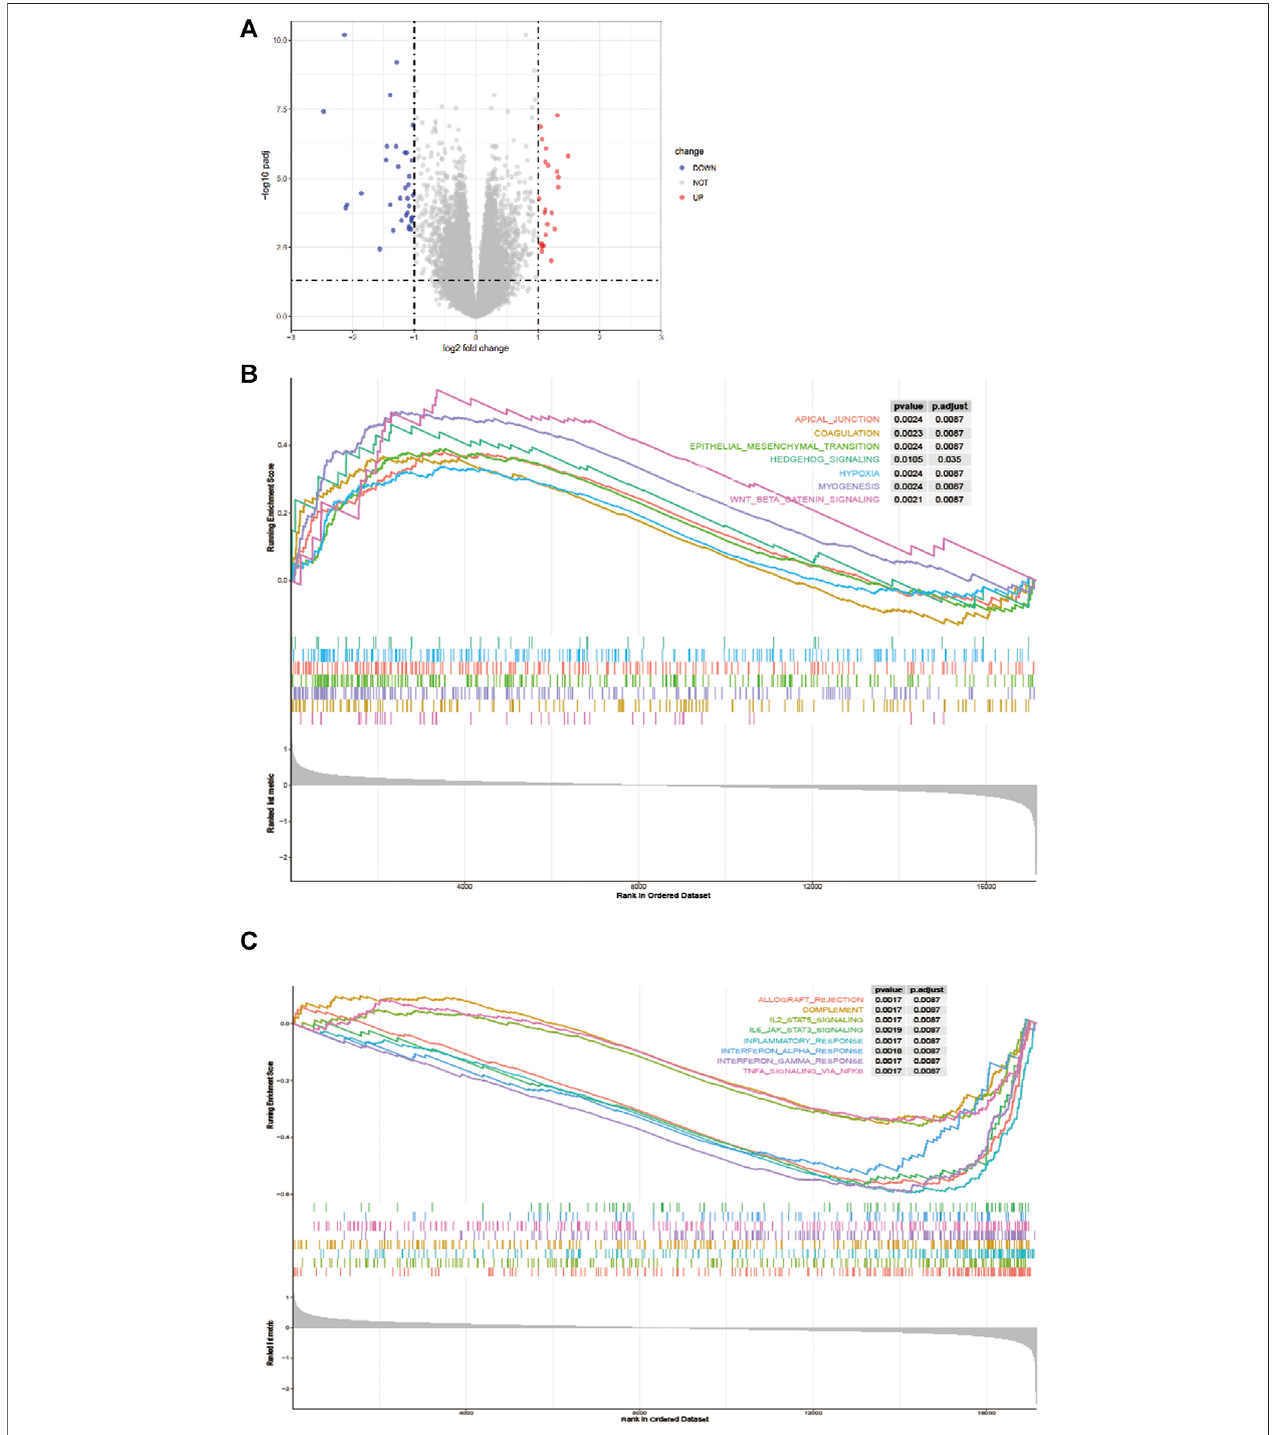
FIGURE5 | Difference analysis. (A) Avolcanomap shows different EMT-related genesof thehigh -and low-risk groups. GeneSet EnrichmentAnalysis (GSEA) for identifying the signi fi cant pathway associated with the high-risk group (B) and low-risk group (C) .